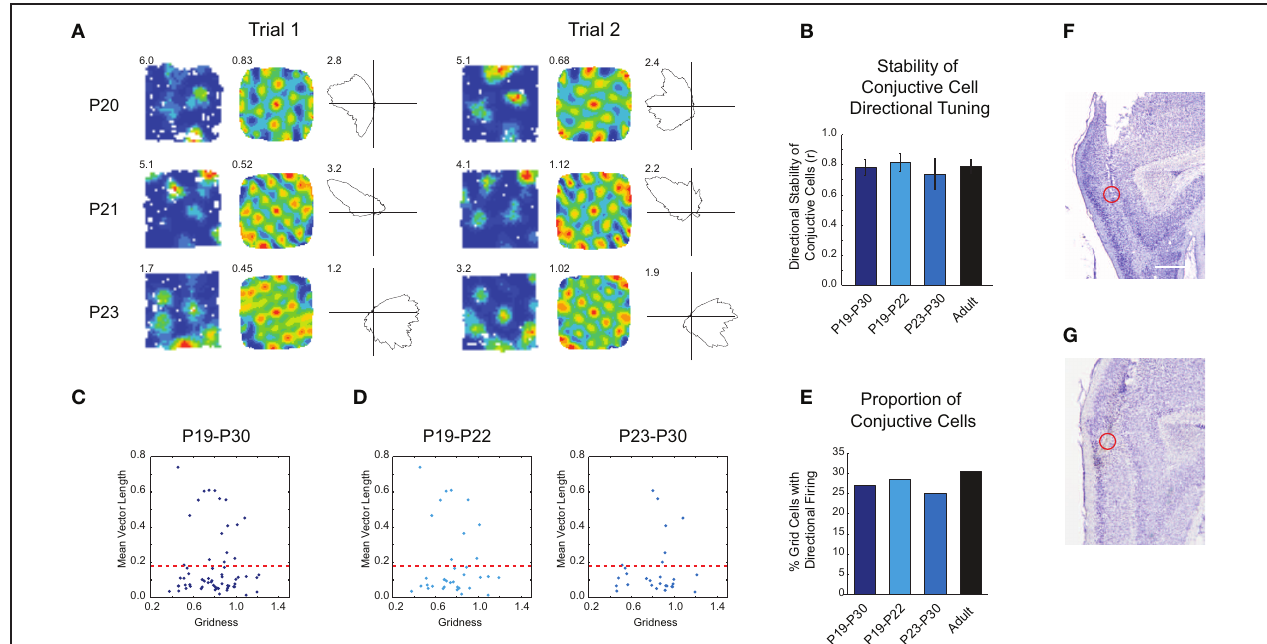
FIGURE 3 | Conjunctive grid-head direction cells exist at the earliest stages of grid cell development. (A) Three example of conjunctive cells recorded from three different rats at P20, P21, and P23, for two consecutive trials. For each trial, the left-hand column shows the firing rate map with peak firing rate, the middle column the auto-correlogram with the gridness score, and the right-hand column the directional firing rate map, with the peak directional firing rate. The directional firing correlate is stable between consecutive trials. (B) The mean stability of the directional correlate of conjunctive cells is at adult levels from the earliest emergence of conjunctive cell firing. Bar chart shows mean inter-trial stability of the directional